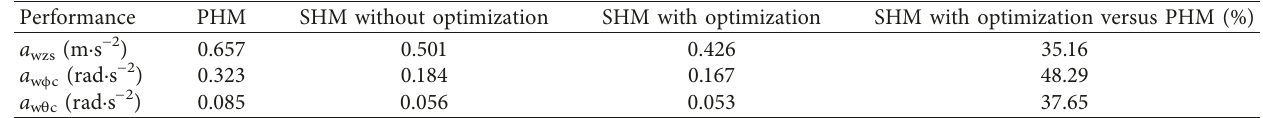
Figure 13: Results of the acceleration responses under a high excitation frequency, 35Hz, of the drum. (a) Vertical driver’s seat. (b) Cab’s pitch angle. (c) Cab’s roll angle. Table 3: The weighted RMS values under a low excitation frequency, 28Hz, of the drum.